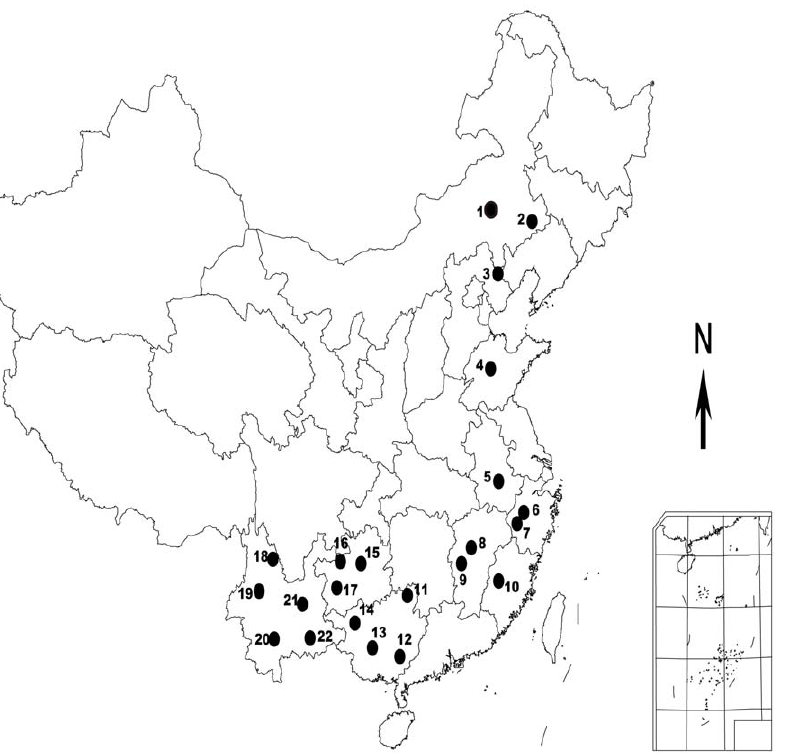
Figure 1. Sampling sites of six closely related Dendrolimus pine moth species in China. Detailed geographical information about sampling sites was deposited in Appendix S1. except haplotype CS11) and 2–9 step mutations from haplotypes of D. punctatus and D. tabulaeformis (gaps as ‘‘5th’’ status; except CS11) (Fig. 4bc). Haplotypes from D. tabulaeformis and D. punctatus